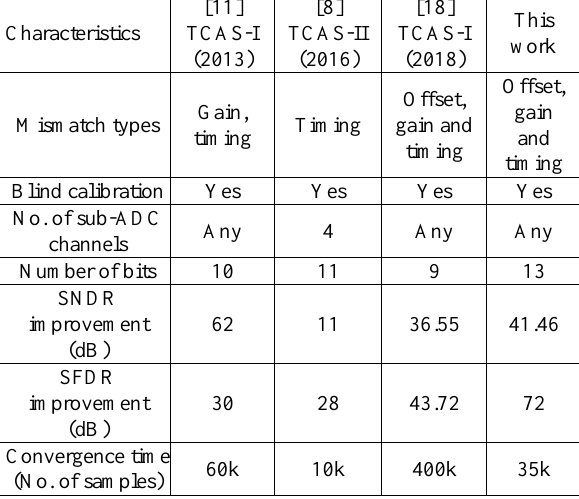
Table 2. A comparison of the proposed with